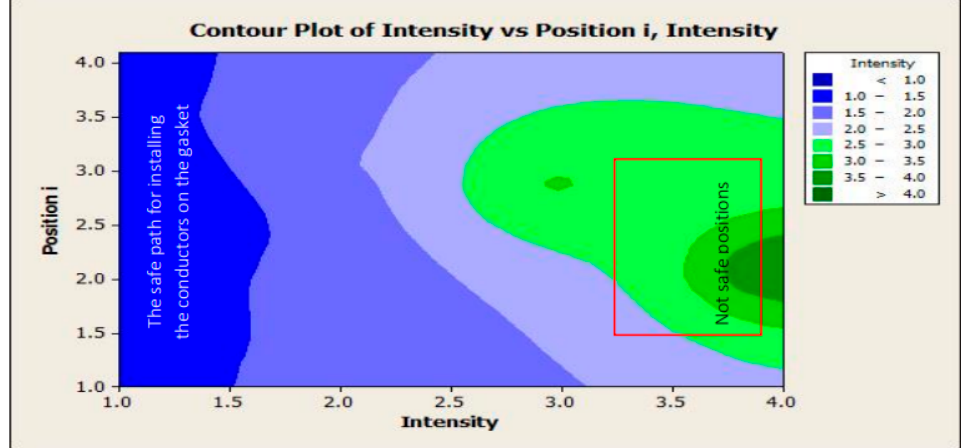
Figure 15. The strip cross section for TEG legs affects the cracks’ span. Hint: preferred significant values.